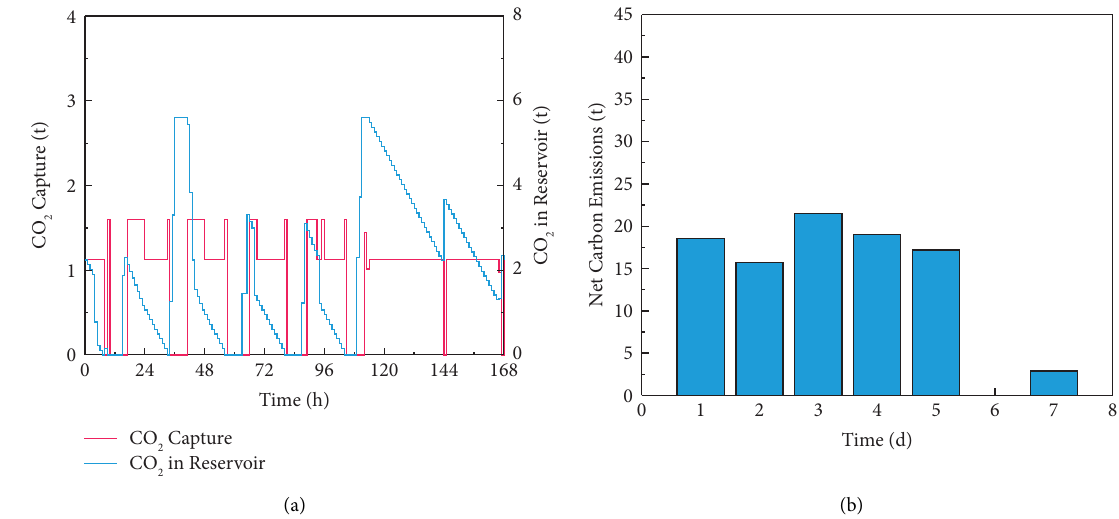
Figure 8: Operation condition of the carbon capture gas turbine when λ C � 80 E . (a) Carbon capture and CO emissions of the gas